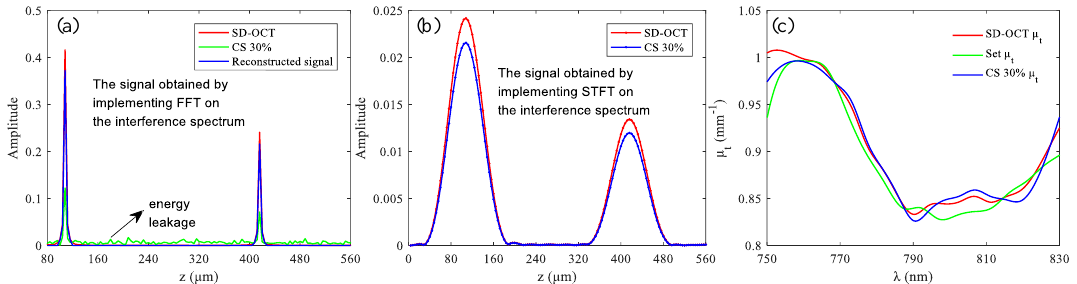
Figure 4. Simulation results of functional sensing. ( a ) The signals obtained by IFFT processing of spectral data; ( b ) the signals obtained by STFT processing of spectral data; and ( c ) extinction coefficient spectrum µ t ( k ) .